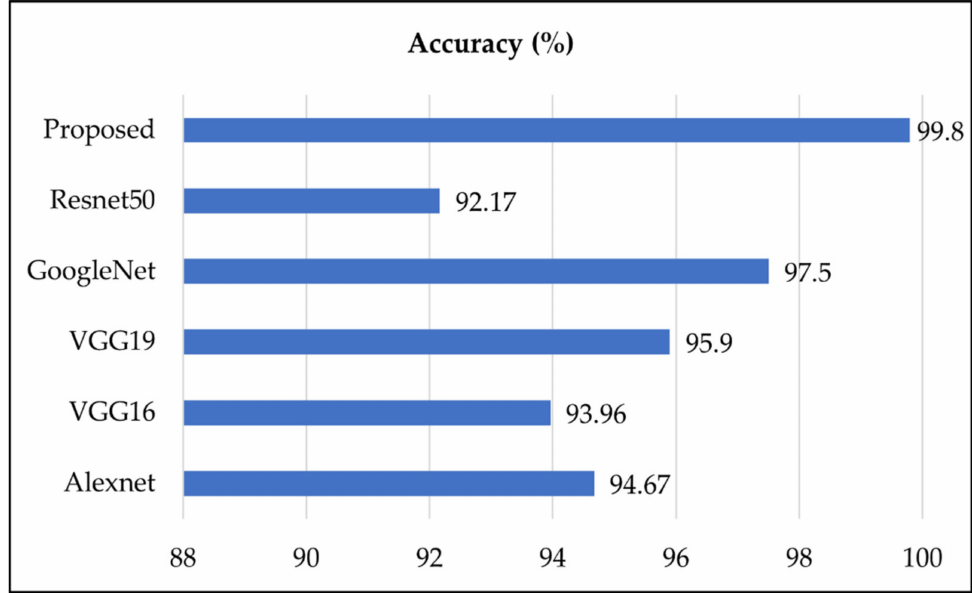
Figure 8. Proposed stomach disease recognition model comparison with CNN